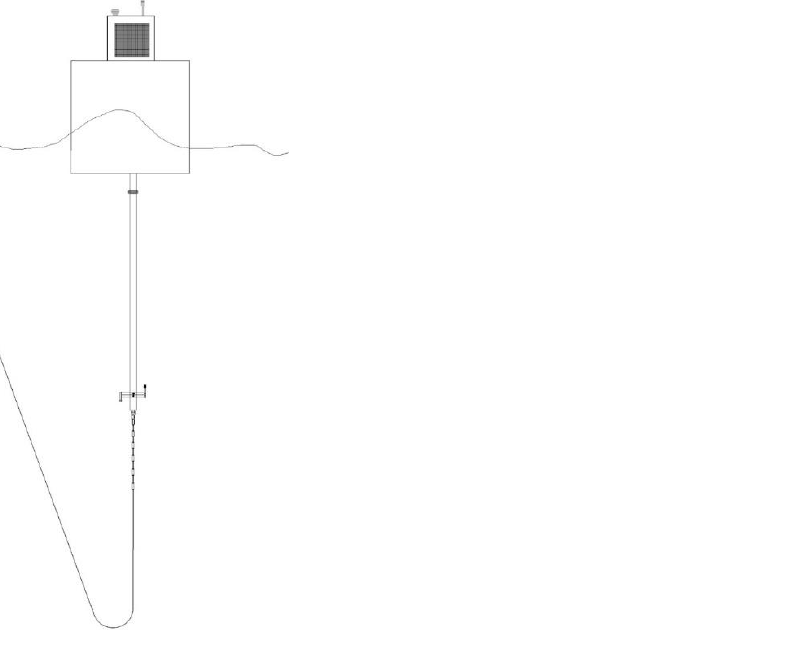
Figure 2. The scheme of one autonomous marine monitoring station.